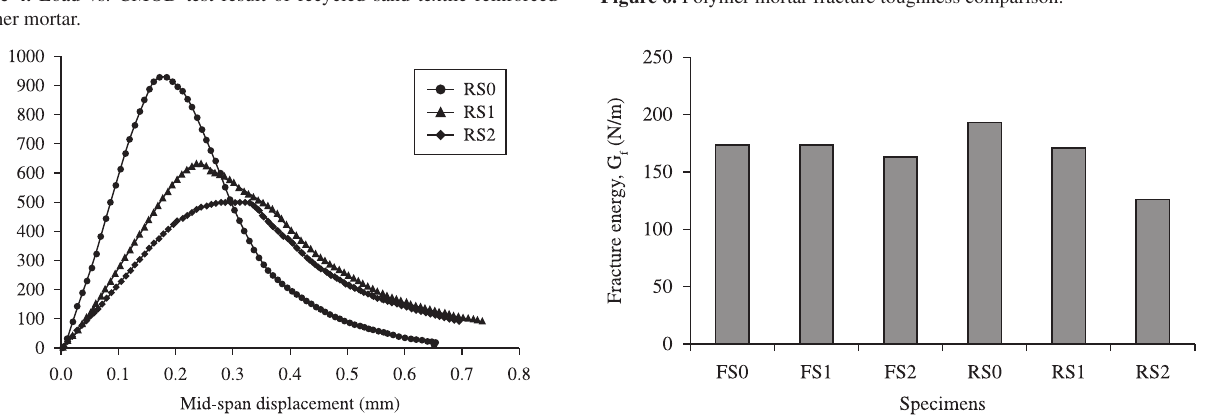
Figure 6. Polymer mortar fracture toughness comparison.